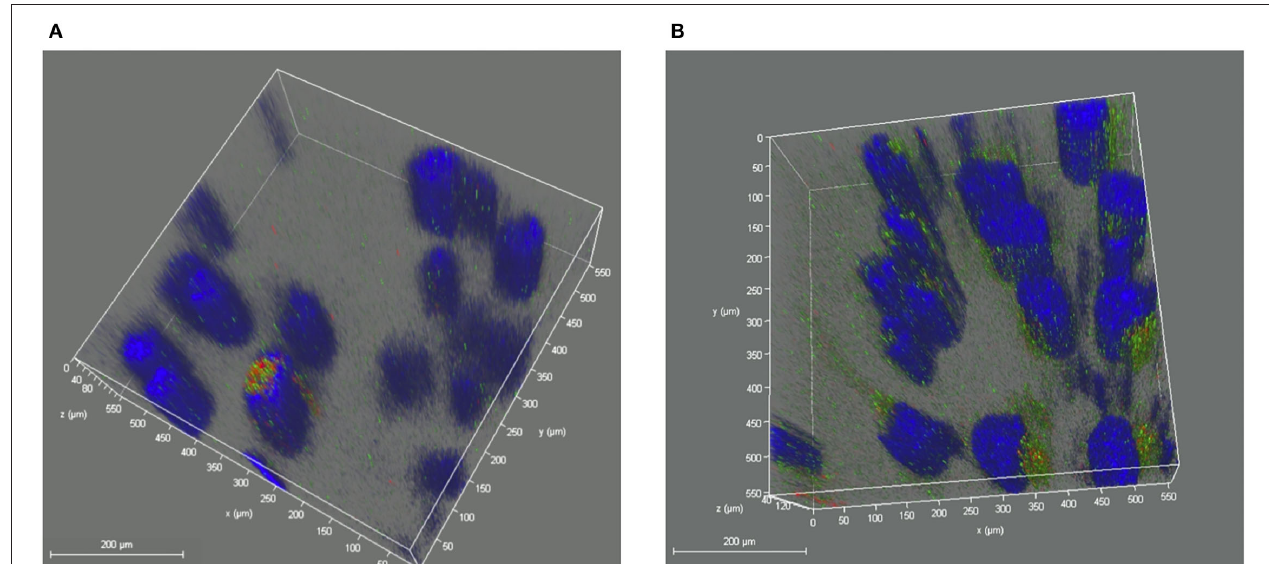
FIGURE 10 | Re-constructed 3D analysis of cisplatin distribution when delivered with or without milk-exosomes. (A) Representative re-constructed 3D image of cis-FITC in A2780CP cells with milk-exosome delivery. Red represents endosomes, green represents cis-FITC, and blue represents DAPI stained nuclei. (B) Representative re-constructed 3D image of cis-FITC in A2780CP cells with milk-exosome delivery. Red represents endosomes, green represents cis-FITC, and blue represents DAPI stained nuclei. Scale bars are shown to the